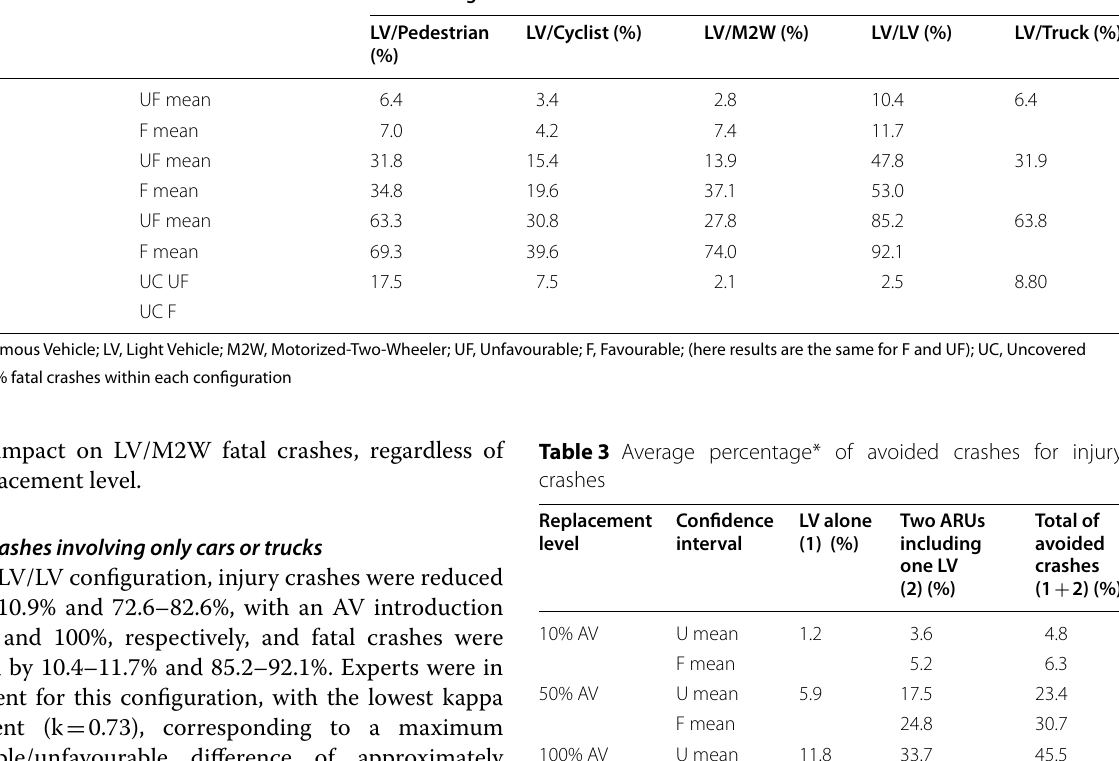
Table 2 Average percentage* of avoided fatal crashes by configuration